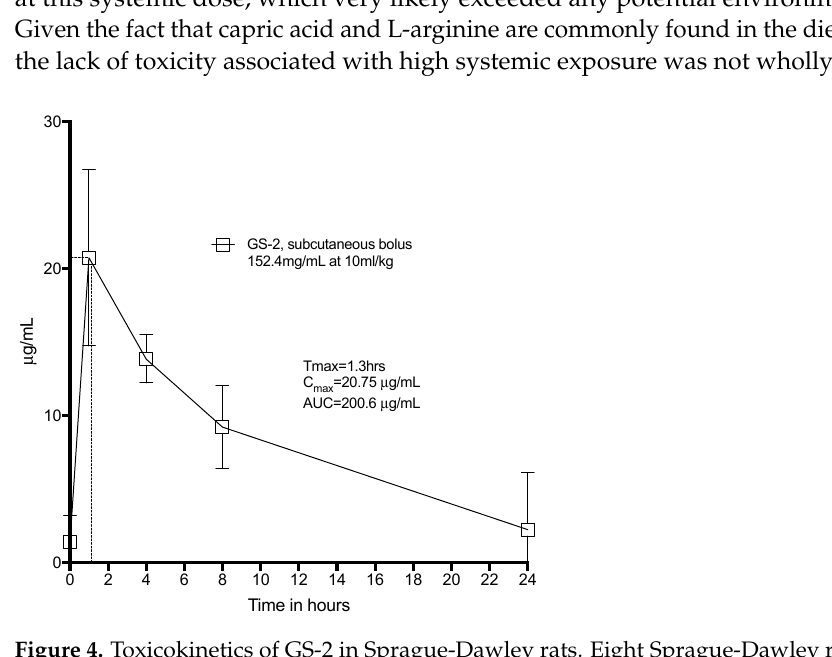
Table 5. Testing of GS-2 (30 mg/mL) with thymol (5 mg/mL) using TGA Option C disinfectant test- ing methods (8 min exposure) in 5 technical replicates. A pass result required at least 2 of the 5 tubes to be clear (i.e., no growth) after 48 h.